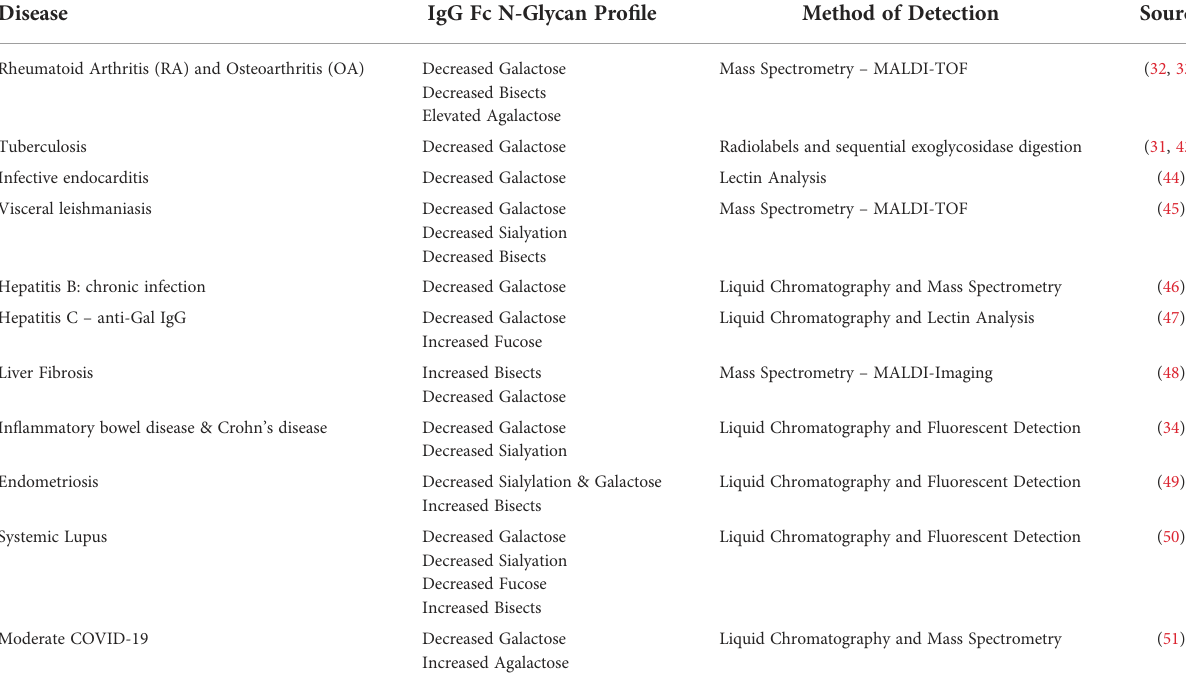
TABLE 1 Altered IgG N-glycan Pro fi les Detected in In fl ammatory